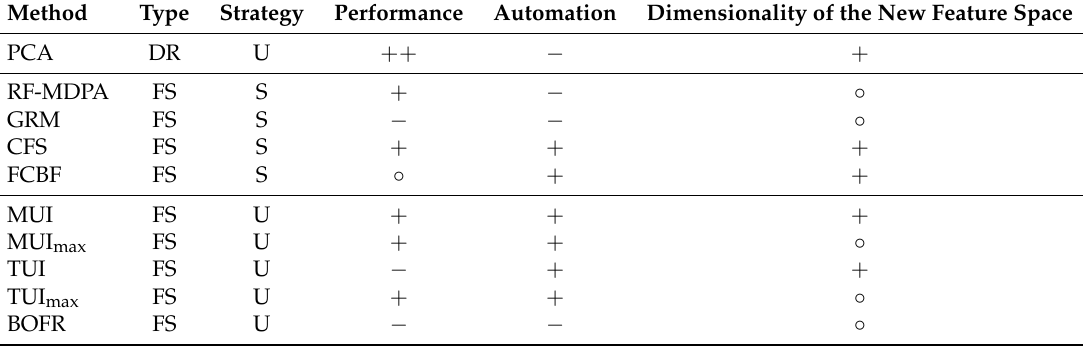
Table 6. Summarizing overview addressing the involved feature sets: we distinguish between dimensionality reduction (DR) and feature selection (FS) and take into account supervised strategies (S) and unsupervised strategies (U) when judging about the pros and cons of involved